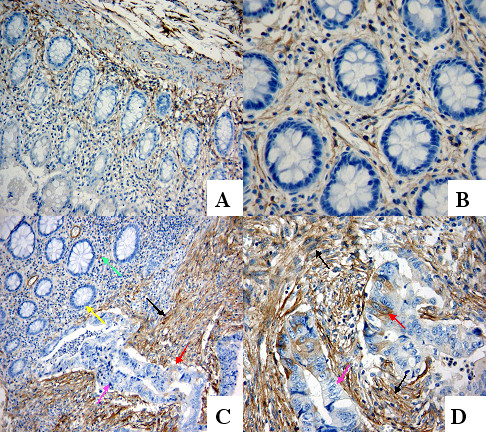
Endosialin expression in rectal normal mucosa and in rectal cancer (representative images from different groups). (A and B) Weak expression in the fibroblasts and capillaries in the stroma, and lack of expression in epithelial cells of normal mucosa ((A) ×100 and (B) ×400). (C) Strong expression in fibroblasts of tumour-associated stroma (black arrow) and weak expression in fibroblasts of normal mucosa (green arrow), normal epithelial cells are negative (yellow arrow), and a few tumour cells are positive (red arrow) and negative (pink arrow) (×100). (D) Strong expression in fibroblasts of tumour-associated stroma (black arrow) and tumour cells (red arrow), whereas some tumour cells are negative (pink arrow) (×400).